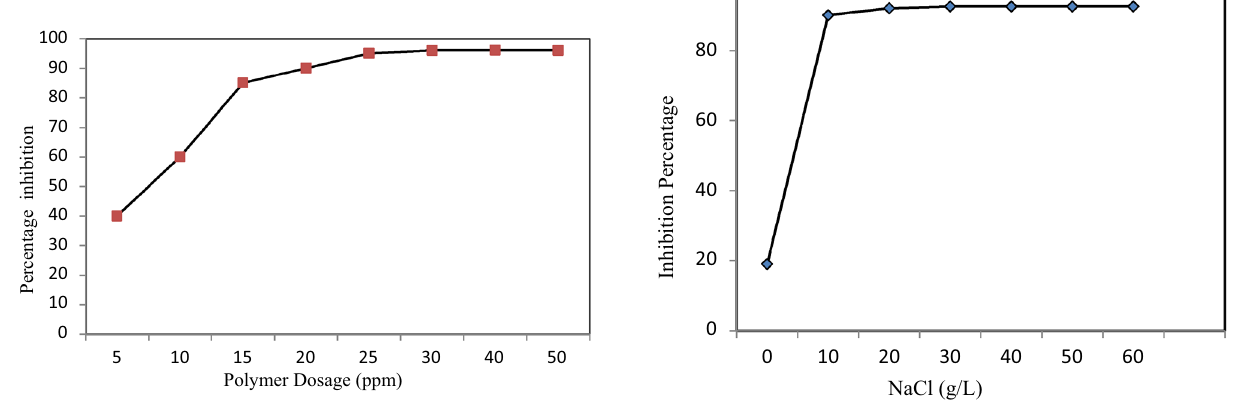
Fig. 7 Effect of NaCl concentration on the polymer inhibition (Inhibi- tor dosage of 30